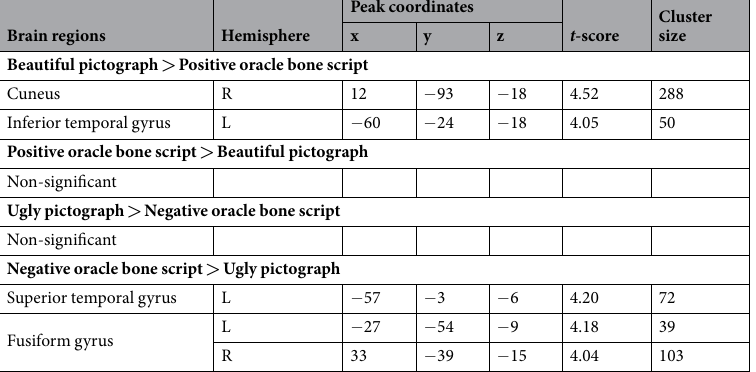
Table 4. Cortical networks of the analysis of variance between pictographs and oracle bone scripts. Note: Coordinates refer to the stereotactic space of the Montreal Neurological Institute. The statistical significance refers to p < 0.001 at voxel level (uncorrected), p < 0.05 at cluster level (FWE corrected).